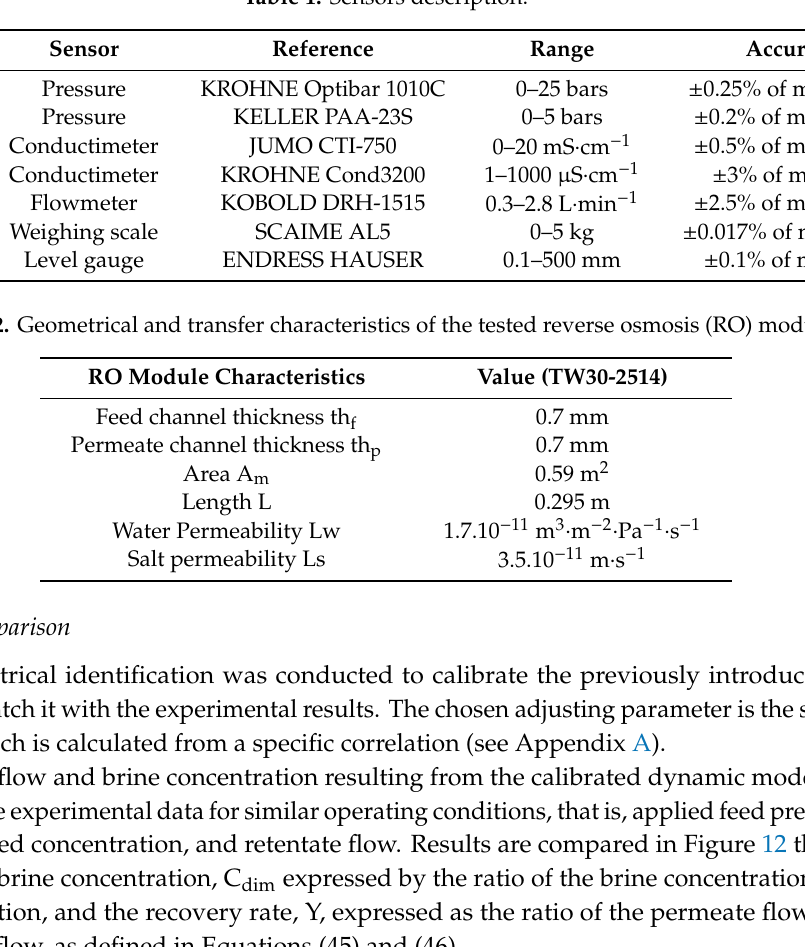
Table 1. Sensors description.